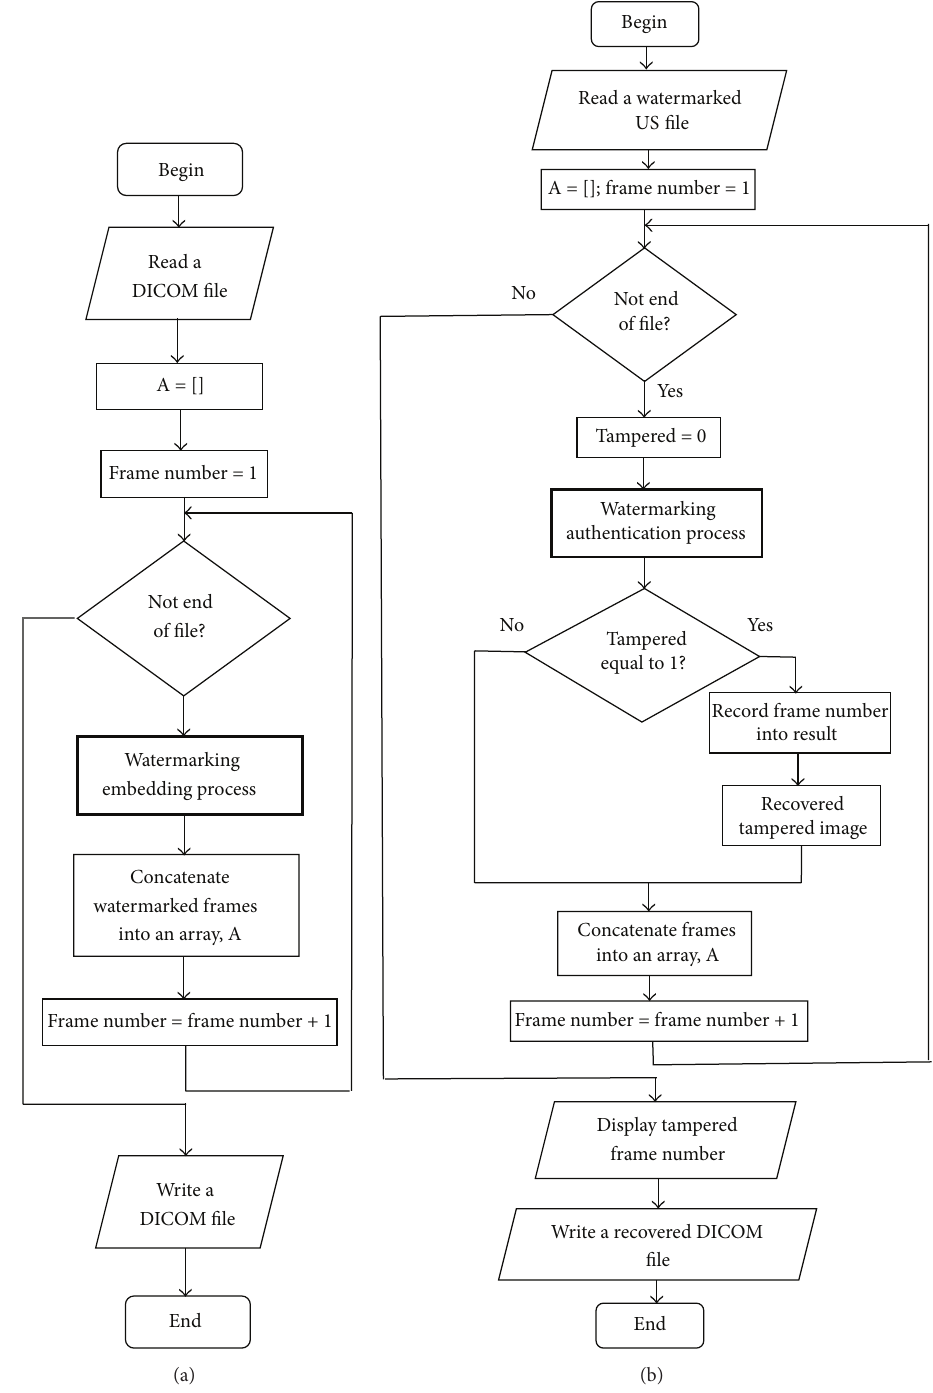
Figure 4: Program flow chart for (a) sequential watermarking embedding process and (b) sequential watermarking authentication process.